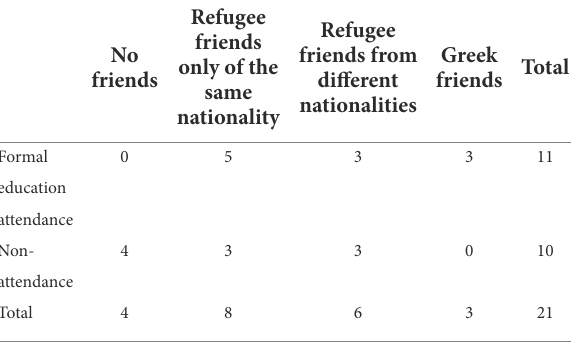
TABLE 4 Refugee children’s friendships and age.